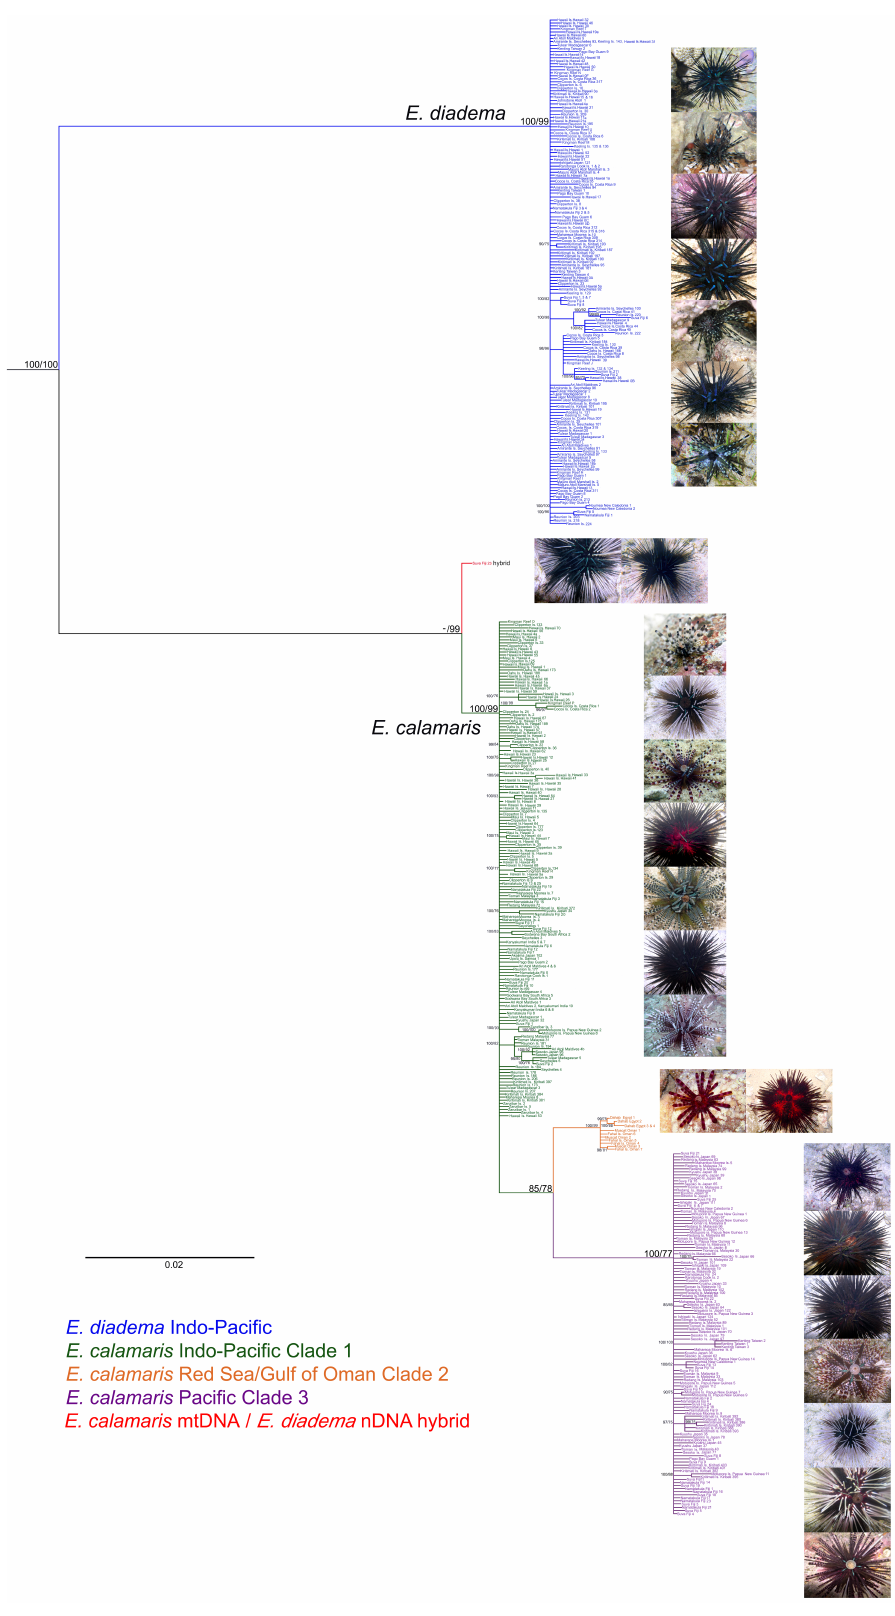
Figure 1. Phylogeny of Echinothrix based on concatenated 16S, ATPase-6, ATPase-8, 28S and Calpain-7 intron sequences reconstructed with RAxML, rooted on Astropyga pulvinata . Clade credibility values > 85% of Bayesian (first number next to node) and > 75% of Maximum Likelihood (second number) reconstruction are shown, –: < 75%. Scale bar reflects number of changes per site, photos show colour morphs present in each molecular